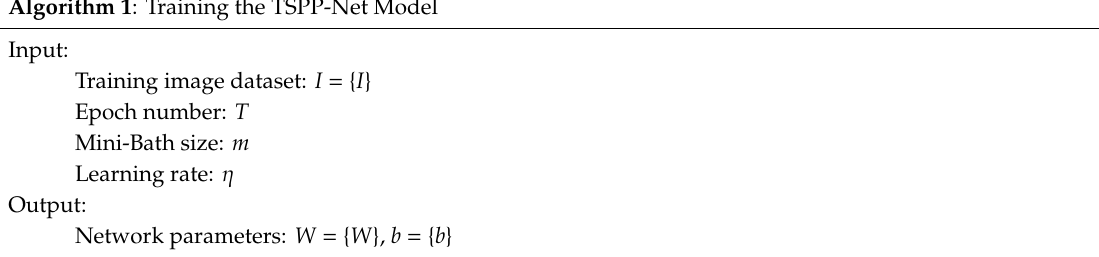
algorithm randomly generate the triplet samples: X = { ( x a the image dataset I . Line 3 shows that the algorithm divide the triplet samples X into the min-batch samples M = { M 1 , M 2 , . . . } and each of M i contains m triplet samples, where M i = { ( x a p p ( x a ) , . . . , ( x a ) }. Line 9–12 describe that the algorithm calculates the gradient , x , x n , x , x n j + 2 j + 2 j + m j + m j + 2 j + m ∗ ∂ L ∗ / ∂ w and ∂ L / ∂ b by back propagation for all the min-batch samples M t . Line 9 represents the m m algorithm updates the network parameters.